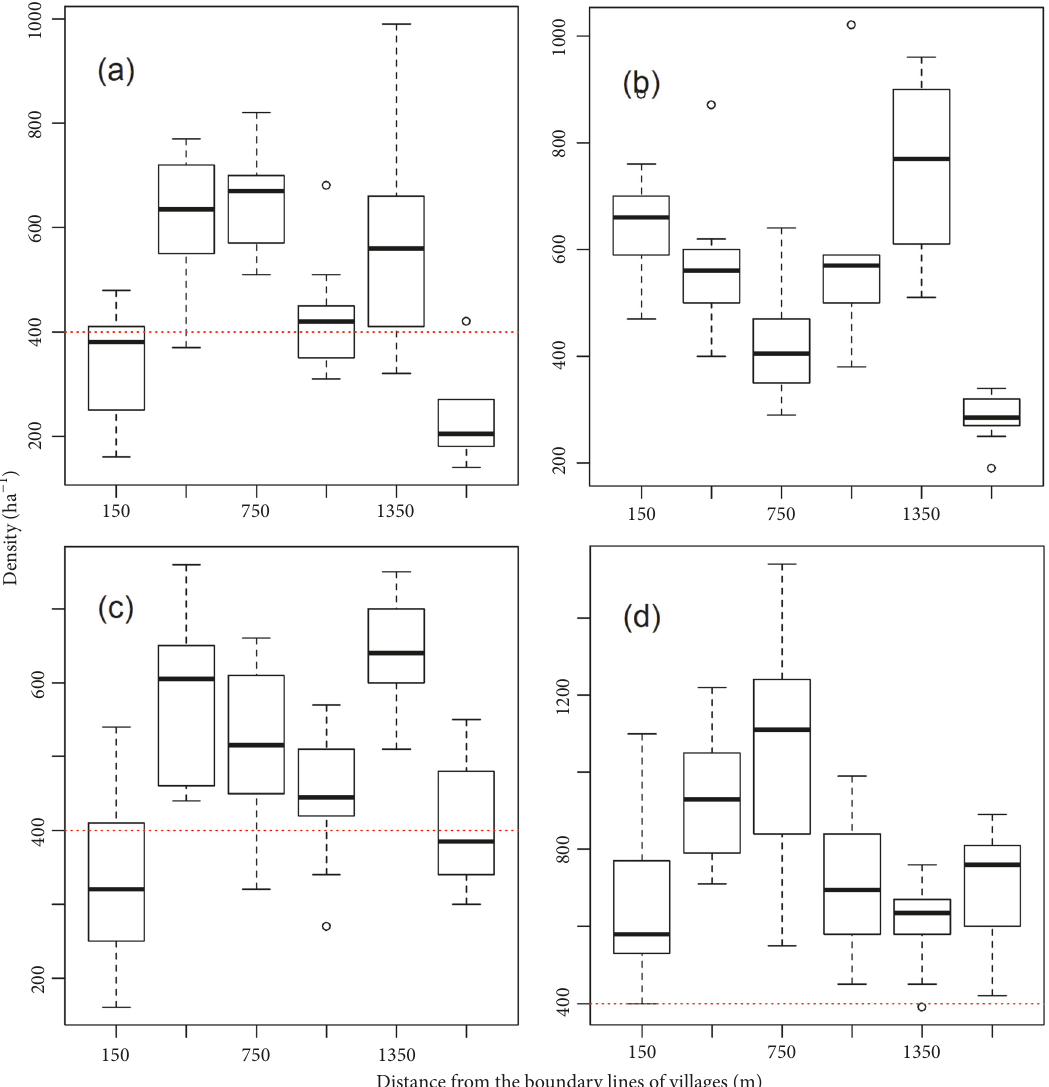
Figure 2: Box plot showing total density (stems ha −1 ) of woody plants from the edge to the interior of the forests. (a) Janajagaran BZCF, (b) Musharni Mai BZCF, (c) Radha Krishna BZCF, and (d) Parsa Wildlife Reserve (control